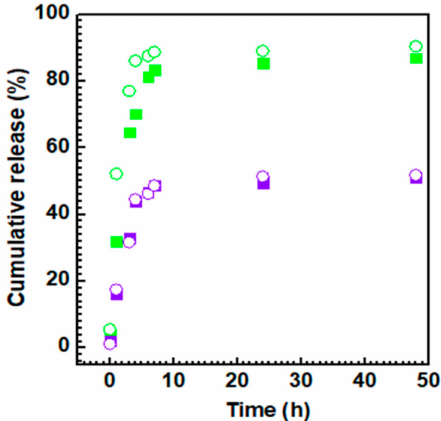
Figure 5. Cumulative drug release of PLGA-CDs1% NPs (green solid square) and PLGA-CDs20% NPs (violet solid square). Drug release after laser irradiation of PLGA-CDs1% NPs (green open circle) and PLGA-CDs20% NPs (violet open